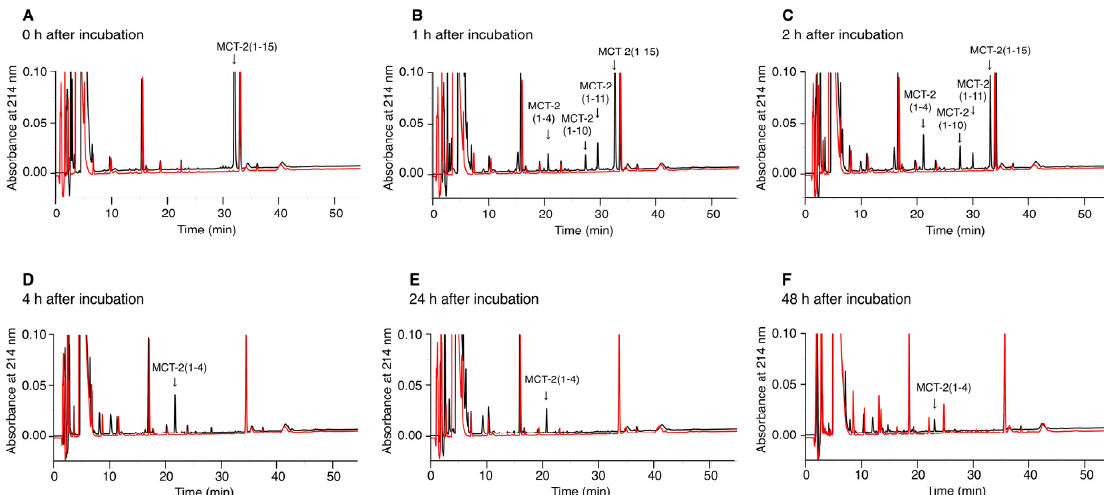
Figure 6. Time-dependent alteration of the molecular forms of MCT-2(1–15) in serum. The alteration of the molecular forms of MCT-2(1–15) in serum was examined as described in the Materials and Methods. Briefly, MCT-2(1–15) was incubated in mouse serum at 37 °C for 0, 1, 2, 4, 24, and 48 h, and samples at those time points were analyzed by RP-HPLC. The panels show the analytical RP-HPLC profile of each sample at 0 ( A ), 1 ( B ), 2 ( C ), 4 ( D ), 24 ( E ), or 48 ( F ) h after incubation. Black and red lines indicate the samples that were incubated with and without MCT-2(1–15), respectively. Analytical conditions: column, 5C 18 column (4.6 × 150 mm); elution with a linear gradient from 10% to 60% CH 3 CN/0.1% trifluoroacetic acid for 50 min; flow rate, 1 mL/min; detection wavelength, 214 nm. The arrows indicate the peaks containing MCT-2(1–15) or its related peptides that were identified by MALDI-TOF-MS.